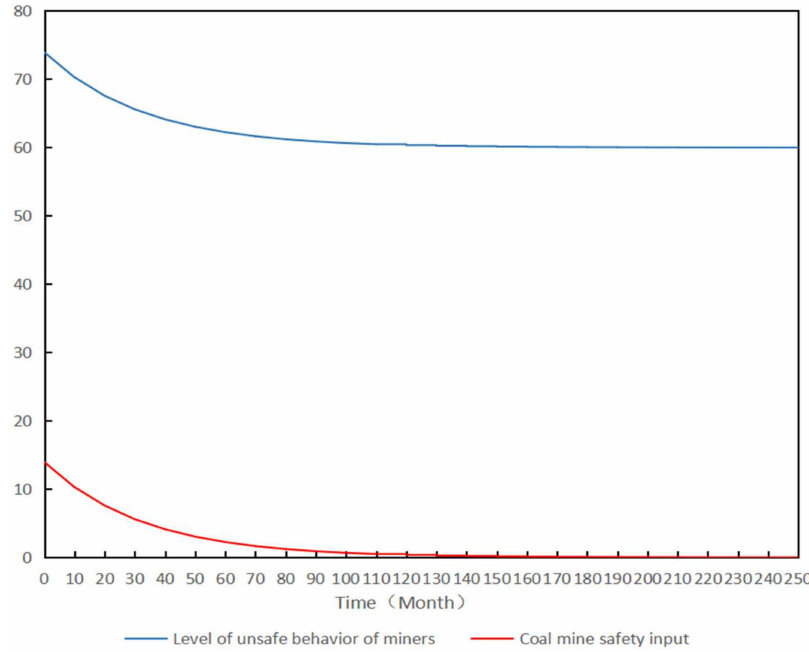
Figure 7. Dynamic influence of coal mine safety input on the level of miners’ unsafe